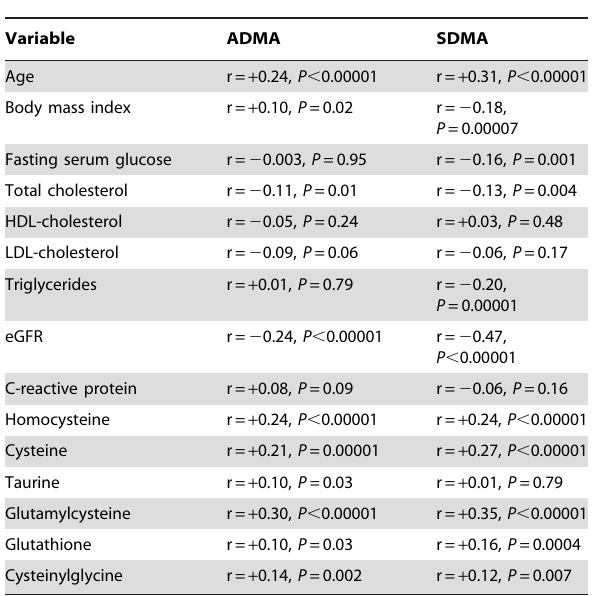
Table 2. Correlations between ADMA and SDMA concentrations, clinical and demographic factors, and biochemical variables.